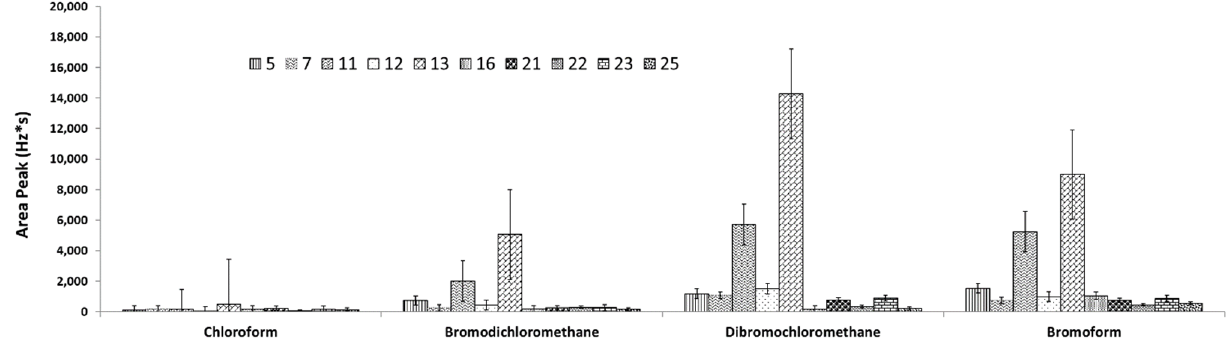
Figure 7. DOE for optimization extraction by HS-SPME showing some representative assays.